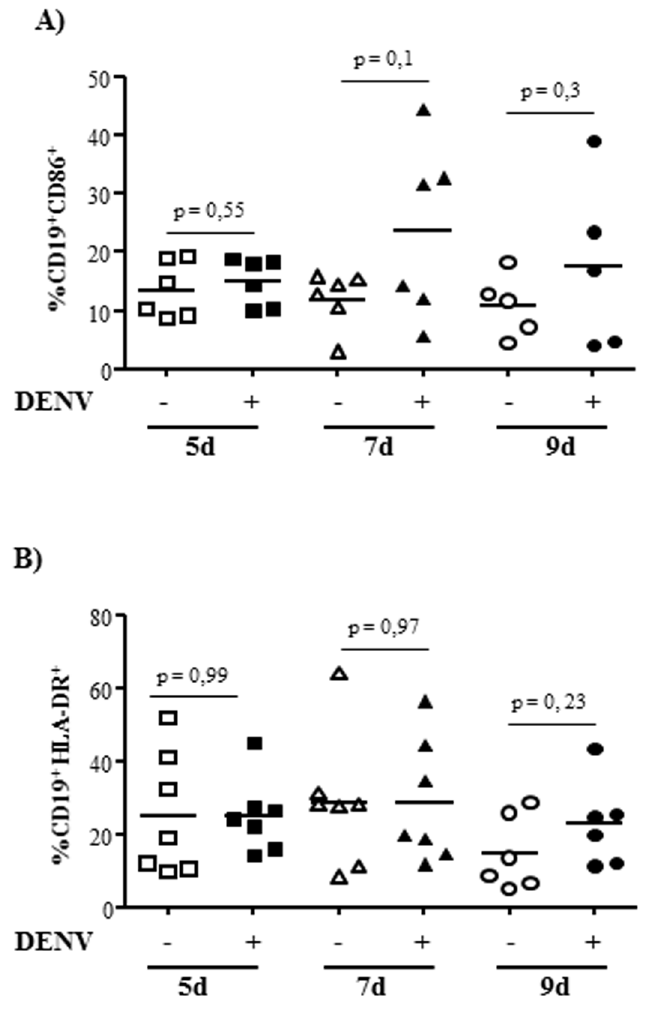
and the expression of CD86 (A) or HLA-DR (B) in CD19+ cells were evaluated by flow cytometry. Each point indicate an individual donor. Statistical analysis were performed and p values are indicated in the